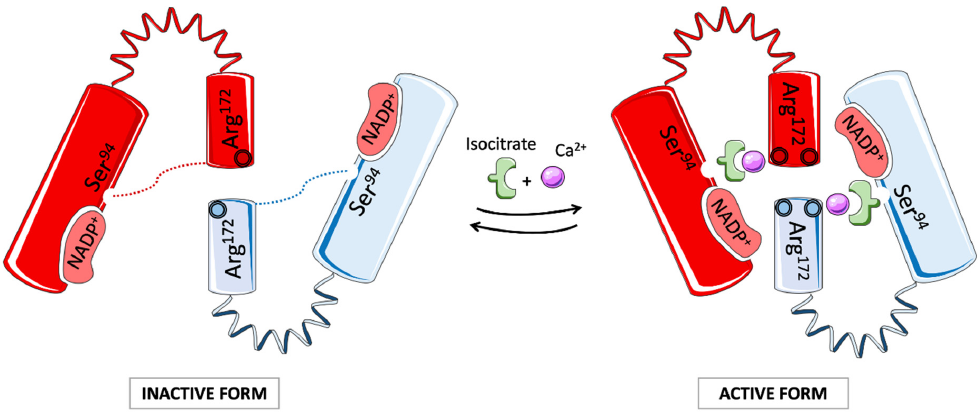
Figure 2. Structure and activation of wild-type IDH2. IDH2 functions as a homodimer, each contain- ing a large NADP+-binding/catalytic domain linked to the small domain by a clasp structure. The open form is maintained by hydrogen bonds between Ser 94 and Arg 172 , which obstruct the active